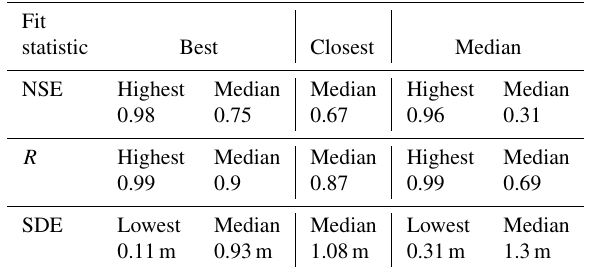
Table 1. Summary statistics from Sect.